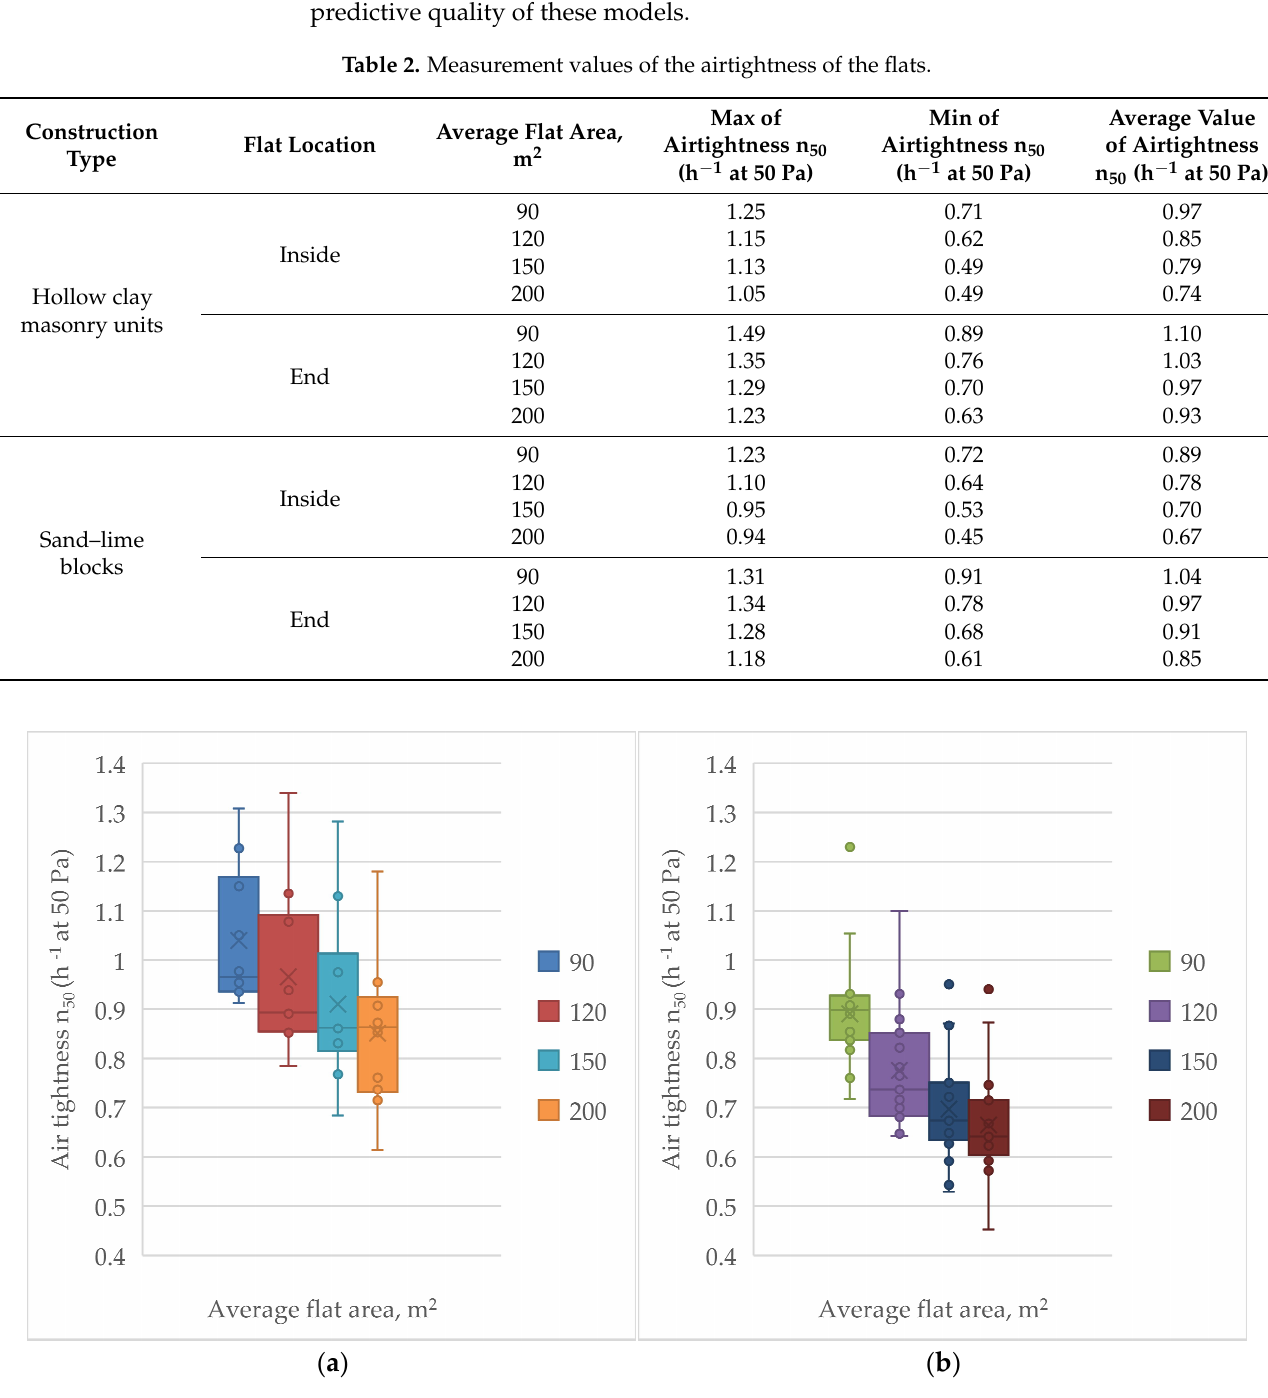
Table 2. Measurement values of the airtightness of the flats.